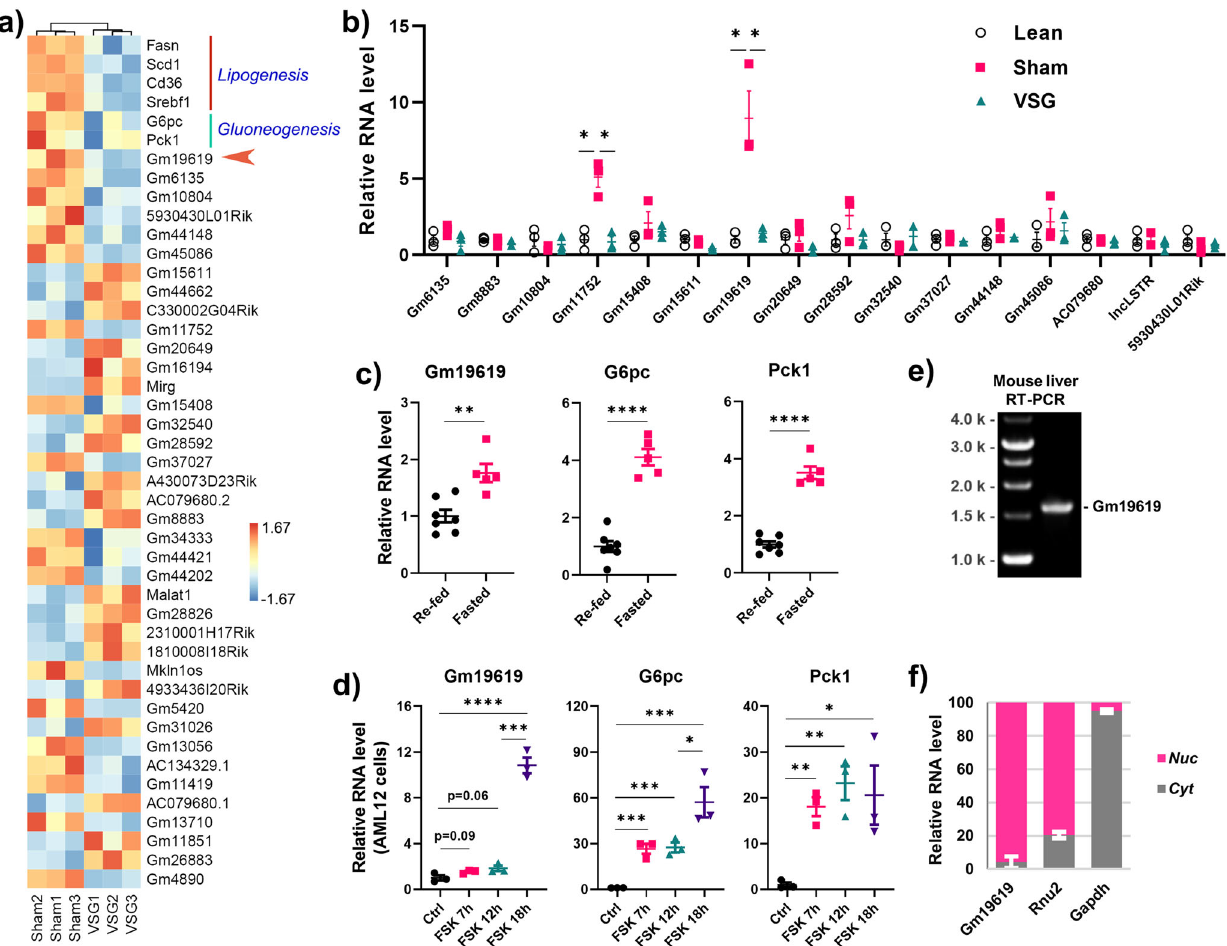
Fig. 1 Gm19619 is a hepatic nuclear lncRNA which can be upregulated in both obese-sham-operated and overnight-fasted mice livers. a Heatmap showing the several protein-coding metabolic genes involved in lipogenesis ( Fasn , Scd1 , Cd36 , and Srebf1 ) and gluconeogenesis ( G6pc and Pck1 ), and the top 40 differentially transcribed lncRNAs with a fold change over 1.67 ( p < 0.05) of the counts in FPKM in the RNAseq data of sham or vertical sleeve gastrectomy (VSG) operated mice livers ( n = 3). b The relative level of different lncRNAs in lean, sham, or VSG-operated mice liver by real-time PCR ( n = 3). c , d The relative RNA level of Gm19619 , G6pc , and Pck1 in overnight-fasted (16 h) ( n = 5) and re-fed (4 h) ( n = 7) mice liver ( c ), and in murine immortal hepatocytes AML12 cells after treatment of 10 μ M forskolin for 7, 12, and 18 h ( n = 3) ( d ). e The full length of Gm19619 RNA was determined by RT-PCR using mouse liver cDNA after its 5 ′ and 3 ′ sequence was con fi rmed by RACE-PCR. f Real-time PCR determined the distribution of Gm19619 RNA in nucleus and cytosol ( n = 3). Rnu2 and Gapdh RNA served as the marker of the nucleus and cytosol, respectively. Two-tailed unpaired t -test. Error bars represent the SEM. * P < 0.05, ** P < 0.01, *** P < 0.001, and **** P <